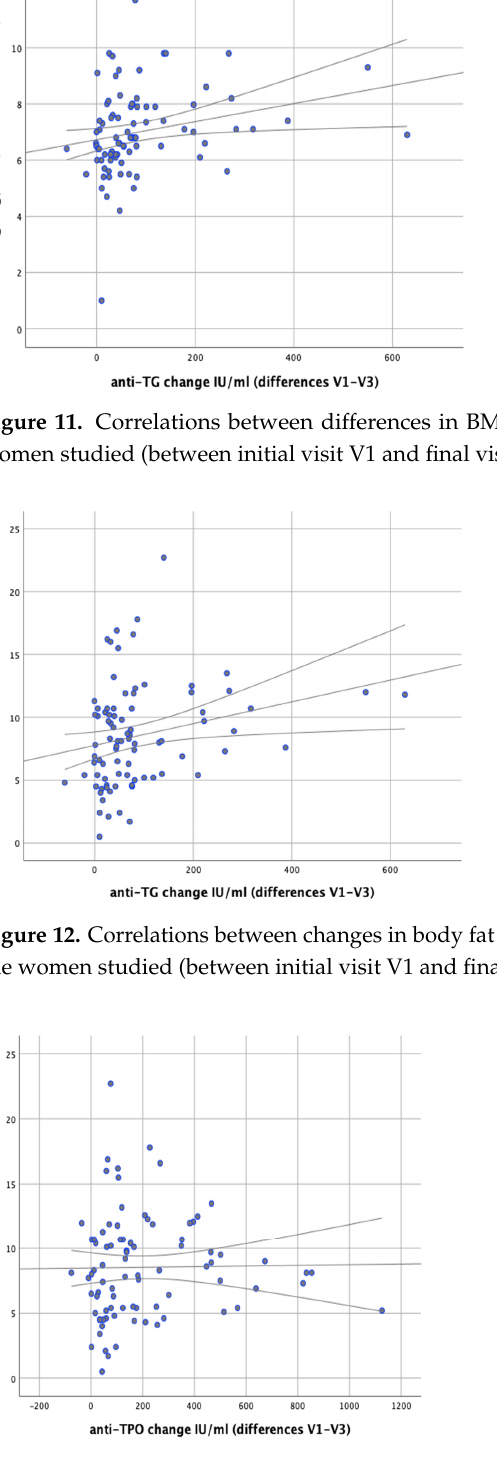
Figure 14 . Correlations between differences in BMI and changes in serum anti-TPO levels in the women studied (between initial visit V1 and final visit V3). 4. Discussion Obesity is a huge global health problem, and the ever-growing number of people with excess body weight is a challenge for doctors and nutritionists. On the one hand, this situation requires specialists to take measures to prevent the growing obesity epidemic, and on the other it forces them to seek more effective forms of obesity treatment and weight reduction—in our case in women with Hashimoto’s disease. As shown by a meta- analysis covering 22 studies, obesity is statistically significantly associated with Hash- imoto’s disease ( p =0.022) and high levels of anti-TPO ( p =0.001) [6]. Many studies indicate a strong relationship between Hashimoto’s hypothyroidism and excess body weight [14– 16]. This is why the authors of many studies have posed the question of whether obesity in these patients is primary or secondary in nature. Omeljaniuket al. studied a group of